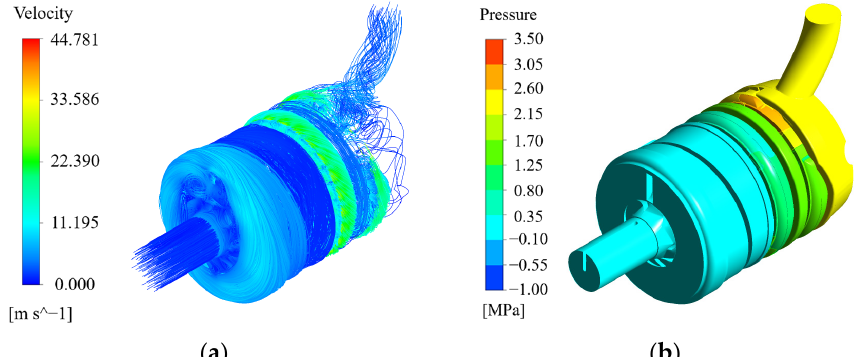
Figure 6. The hydraulic performance simulation results with the SST and DES models at different flow points.